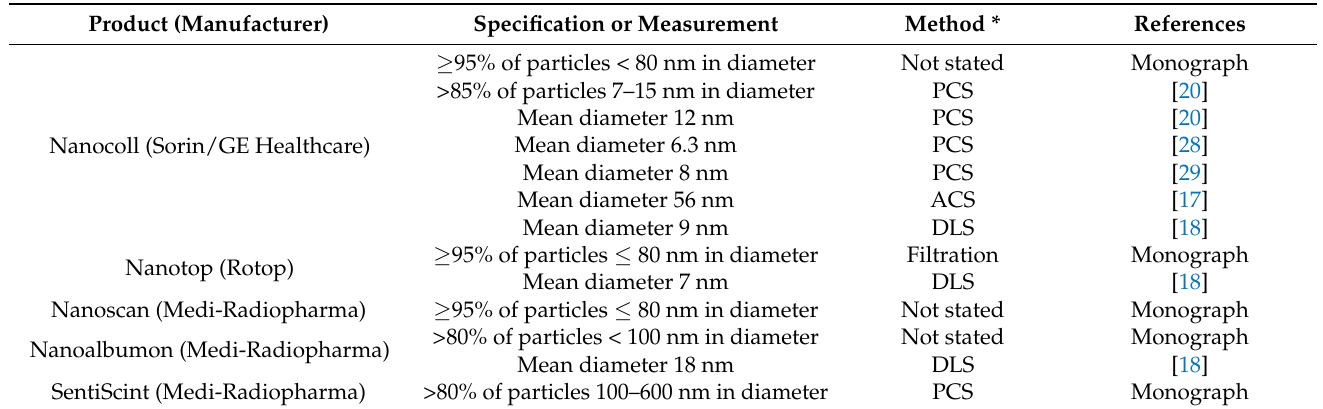
Table 2. Properties of licensed albumin nanocolloid